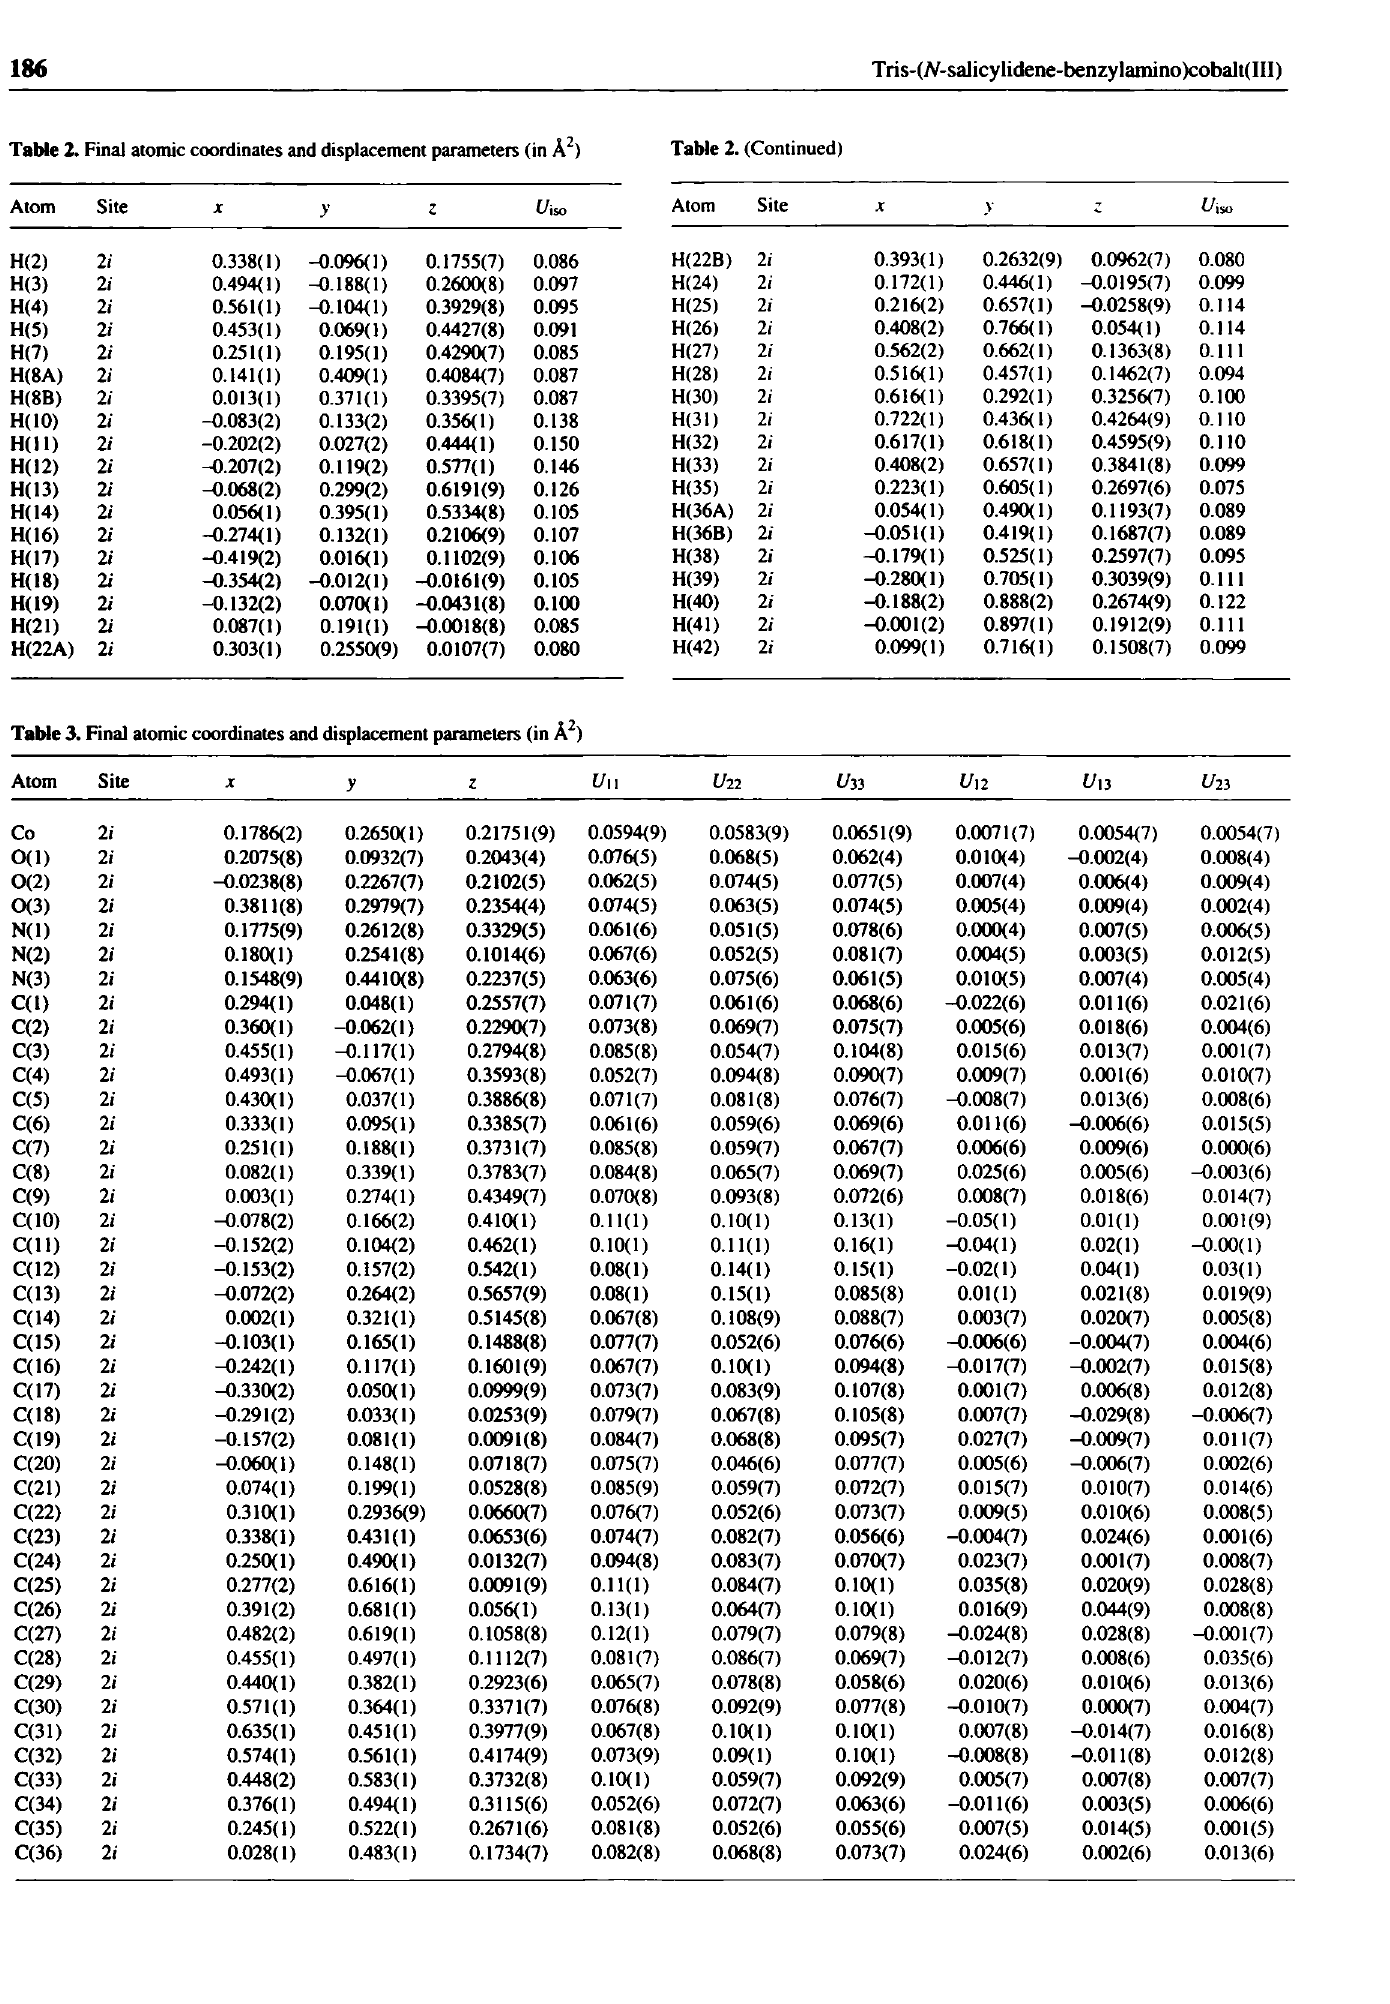
Table 2. Final atomic coordinates and displacement parameters (in Â 2 ) Table 2. (Continued)